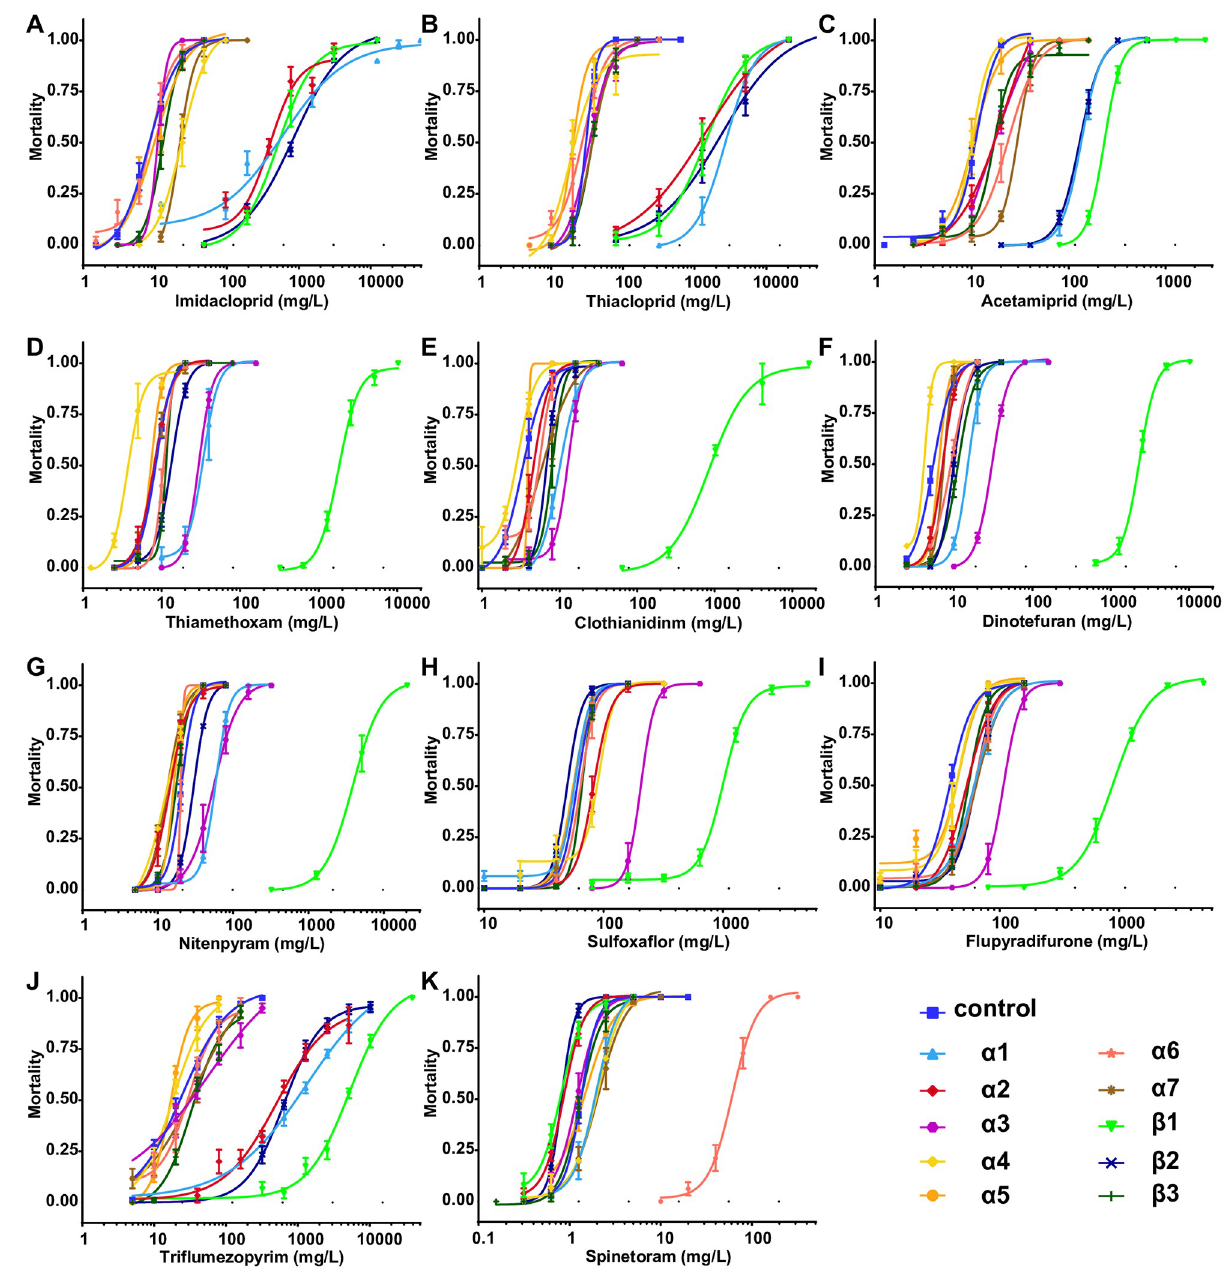
Fig 2. Nonlinear log-dose mortality data for tested insecticides against ten Drosophila nAChR homozygous mutants, including eight null alleles and two point mutation alleles ( α 4 T227M and β 1 R81T ). Mortality (0–1 means 0–100% in terms of percentage) of control and mutant female adults after 48 hours of exposure to increasing concentrations of insecticides. Error bars represent standard